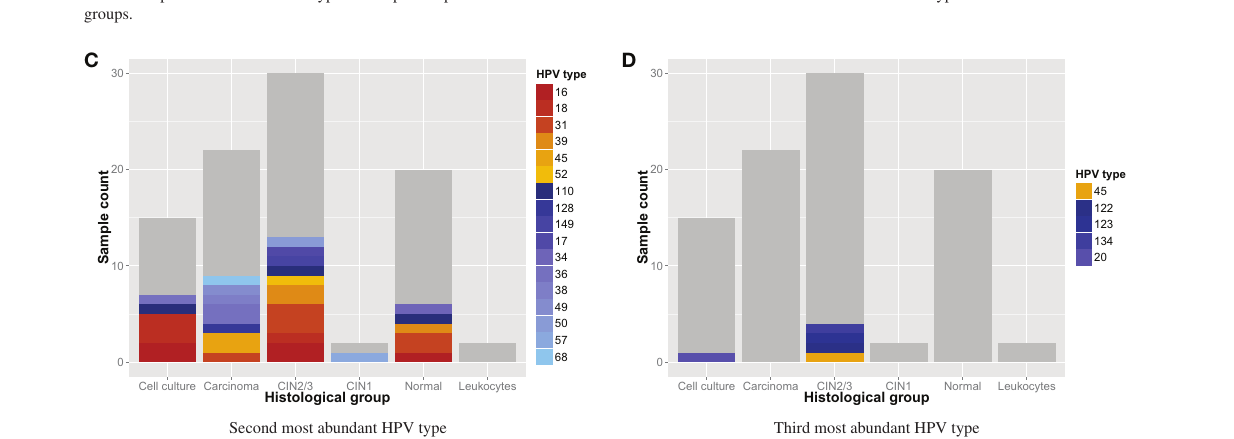
StackedbarplotofnumberofHPVtypesfoundpersamplewithinthedifferent groups.